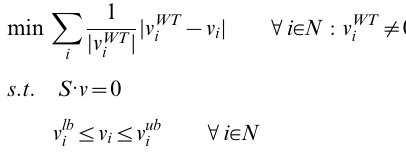
Figure 4. Understanding genetic interactions by using MiMBl. a, b ) The accuracy of genetic interaction predictions by FBA, lMoMA and MiMBl was assessed by calculating the sensitivity and precision for positive (a) and negative (b) interactions. Sensitivity was calculated as the fraction of experimentally observed interactions captured by the algorithm, while precision was estimated as the fraction of experimentally observed interactions among the predicted interactions. c ) Venn diagram showing the overlap of the correctly predicted interactions by FBA, MiMBl and lMoMA. d, e ) Distribution of the graph theoretical distances, within the yeast metabolic network, between the interacting genes captured by FBA (d) and MiMBl (e). As MiMBl also captured the majority of FBA predicted interactions, only exclusive MiMBl interactions are shown in (e). f ) The S. cerevisiae genetic interactions network correctly predicted by MiMBl and/or FBA (FBA – dashed line, MiMBl – dotted line, both – full line). Positive and negative interactions are distinguished by color (orange and blue, respectively) and the opacity of the edges is inversely proportional to the network distance between the corresponding genes. Gray-filled nodes represent genes that display both positive and negative interactions. Gray areas enclose isoenzymes where at least one of them was found to interact with other genes in the metabolic